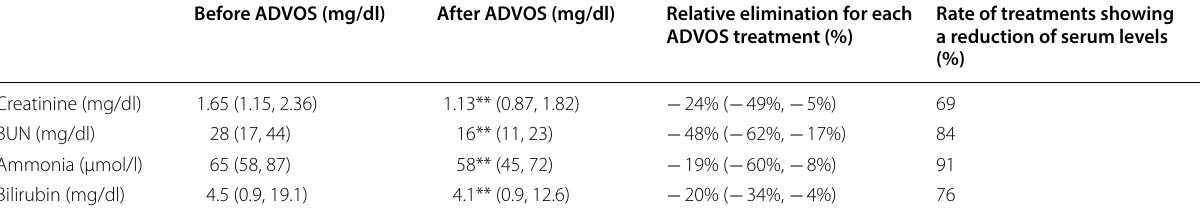
Median (IQ25, IQ75). Non-parametric paired Wilcoxon test ** p < 0.01. Median treatment duration 18.5 h (range 8.25, 22.0)